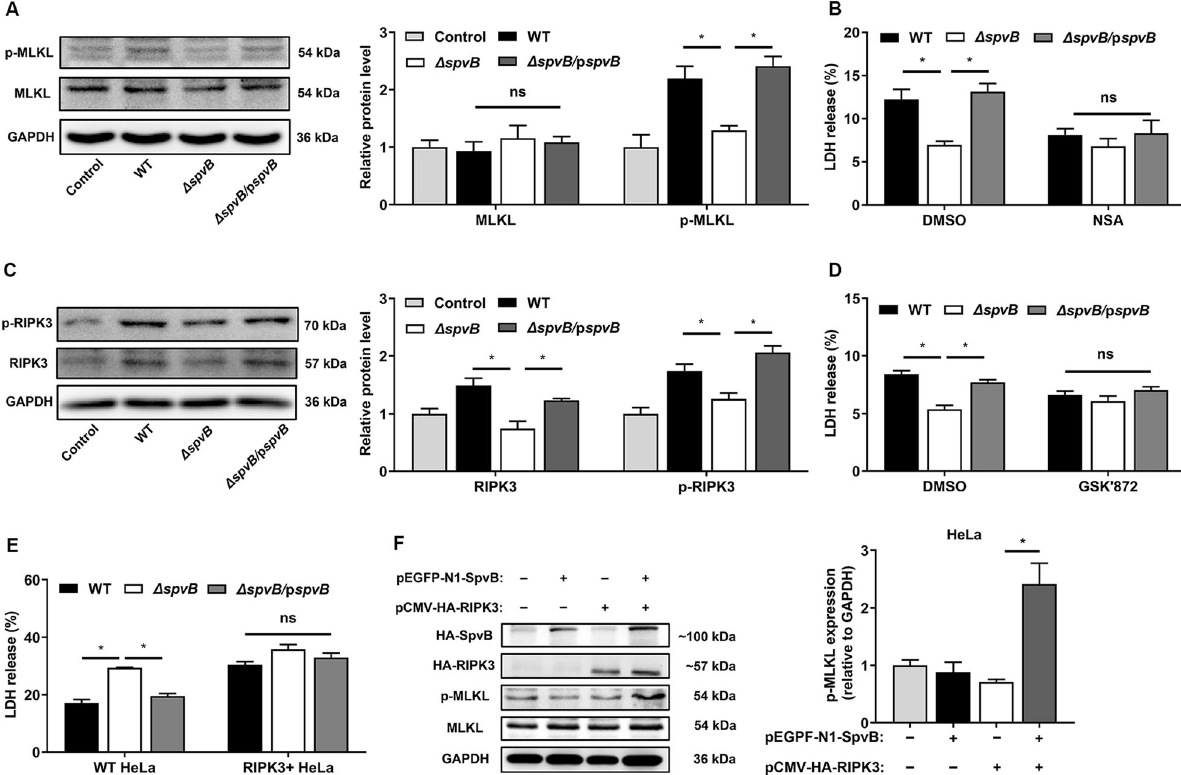
Fig. 2 SpvB promotes necroptosis of IECs. A , C Caco-2 cells were infected with the WT, Δ spvB , or Δ spvB /p spvB S . Typhimurium strain (MOI of 100) and incubated for 4 h. Western blot analysis of the expression of A MLKL and p-MLKL (S358), C RIPK3 and p-RIPK3 (S227). B , D Caco-2 cells were treated with either vehicle (DMSO), B 1 μ M necrosulfonamide (NSA) or D 1 µM GSK ’ 872 for 1 h. The cells were then infected with the WT, Δ spvB , or Δ spvB /p spvB S . Typhimurium strain (MOI of 100) and incubated for 24 h. Aliquots of cellular supernatants were subjected to LDH release assay. E HeLa cells were transiently transfected with pCMV-HA-RIPK3 for 24 h. Cells were then infected with WT, Δ spvB , or Δ spvB /p spvB S . Typhimurium strain (MOI of 100) and cultured for 24 h. Aliquots of cellular supernatants were subjected to LDH release assay. F HeLa cells were transiently transfected with pCMV-HA-RIPK3 and pEGFP-N1-SpvB for 24 h. Western blot analysis of the expression of p-MLKL. Data were analyzed with IBM SPSS Statistics 19 and presented as the mean ± SEM using Student ’ s t -test and ANOVA with S-N-K correction. * P < 0.05; ns not signi fi